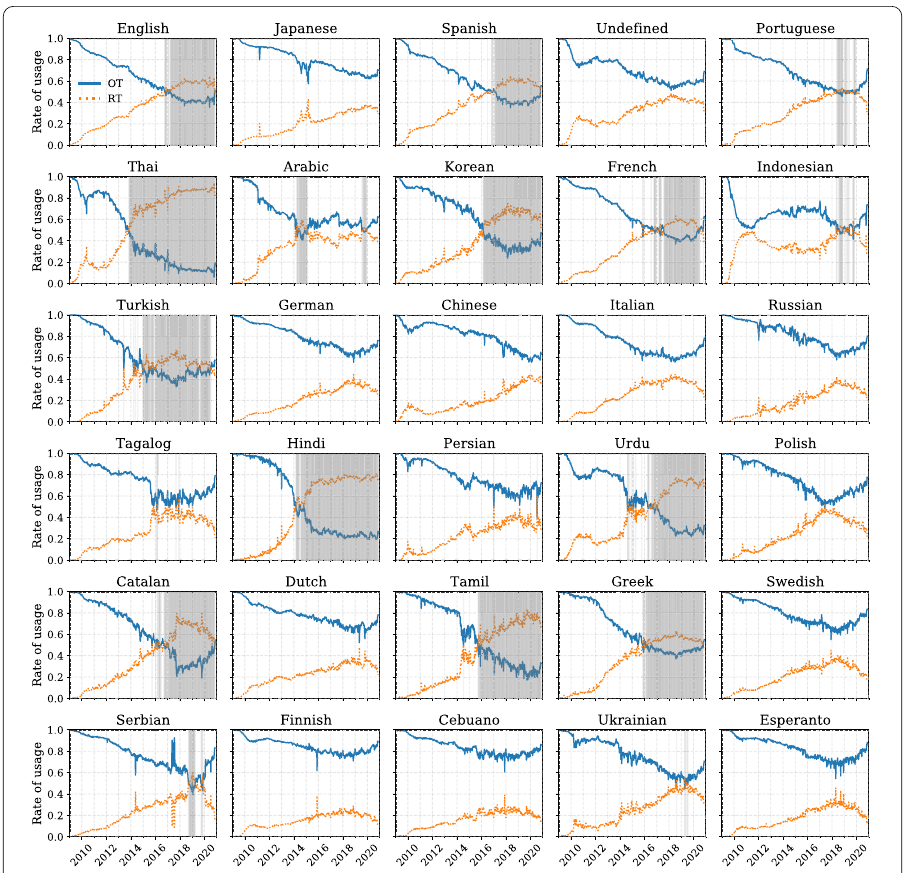
Figure 5 Weekly rate of usage of the top 30 languages (sorted by popularity). For each language, we show a , blue) compared to retweeted messages ( p ( RT ) , weekly average rate of usage for organic messages ( p ( OT ) t , (cid:2) t , (cid:2) orange). The areas highlighted in light shades of gray represent weeks where the rate of retweeted messages is higher than the rate of organic messages. An interactive version featuring all languages is available in an online appendix: